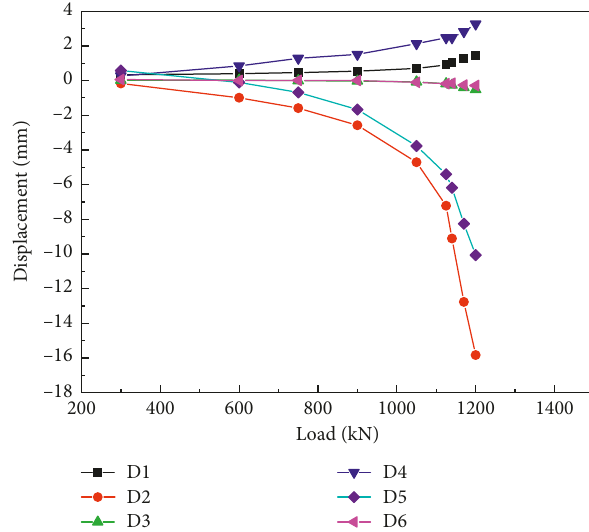
Figure 23: Load-displacement curves in Model